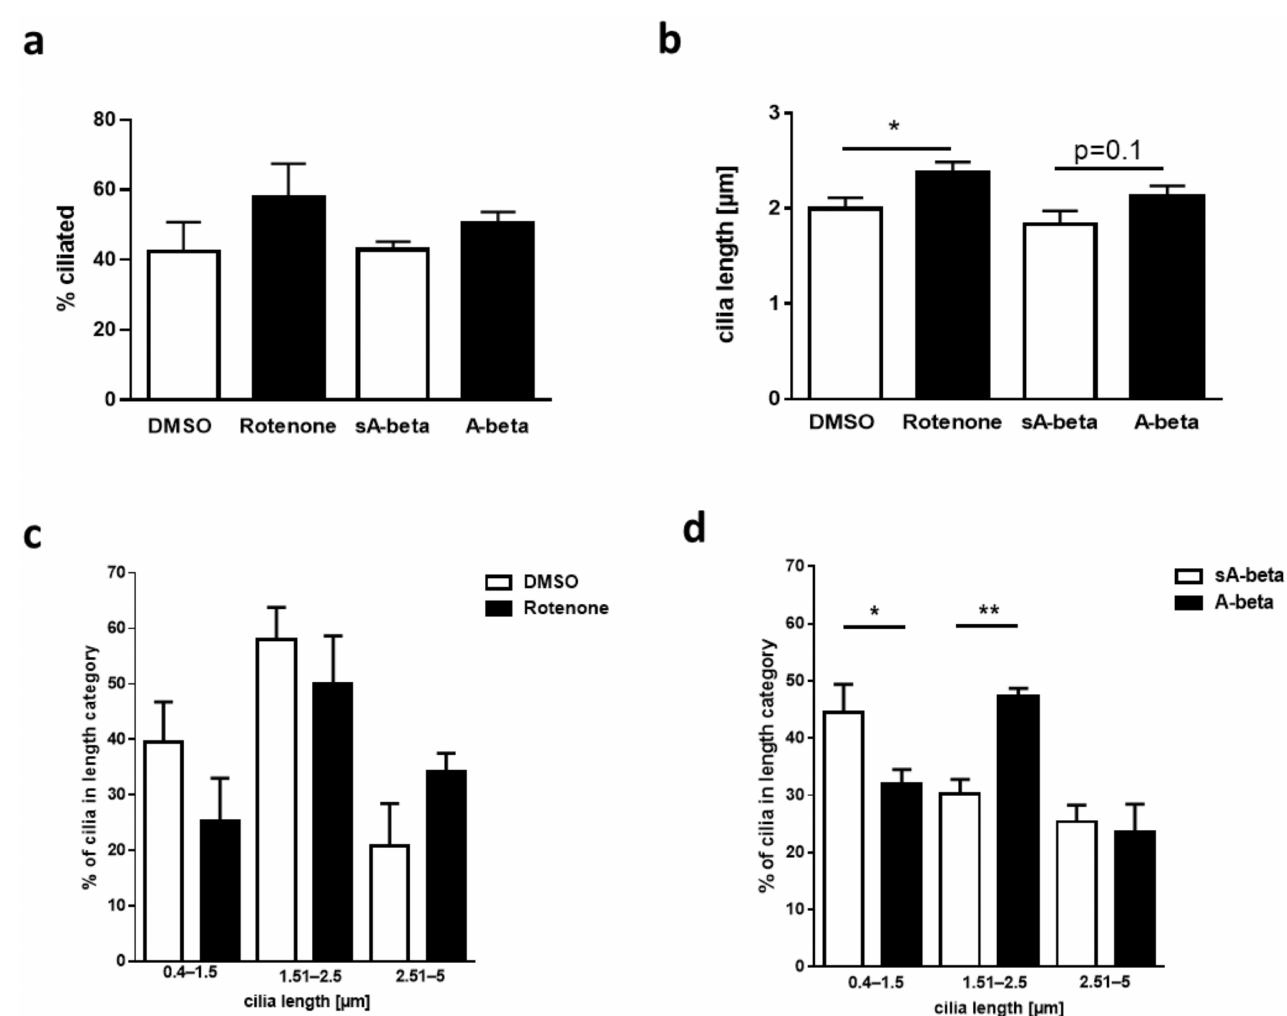
Figure 4. Impact of acute A-beta administration on cilia length of enteric neurons. ( a ) Enteric neurons (DIV3) of wild type mice were treated for 24 h with scrambled peptide (sA-beta), A-beta 42 (both: 2.5 µ M) or Rotenone (0.5 µ M). Cilia characteristics were determined as described in Figure 3 ( n = 76 cilia measured after treatment with DMSO, n = 120 with Rotenone, n = 58 with sA-beta and n = 118 with A-beta). ( b ) Cilia length after treatment. Statistical analysis was conducted using Student’s t -test. Group-stratified mean cilia length after treatment with Rotenone ( c ) or with peptides ( d ). One Way Anova (post-test Fisher LSD; * p < 0.05, ** p <